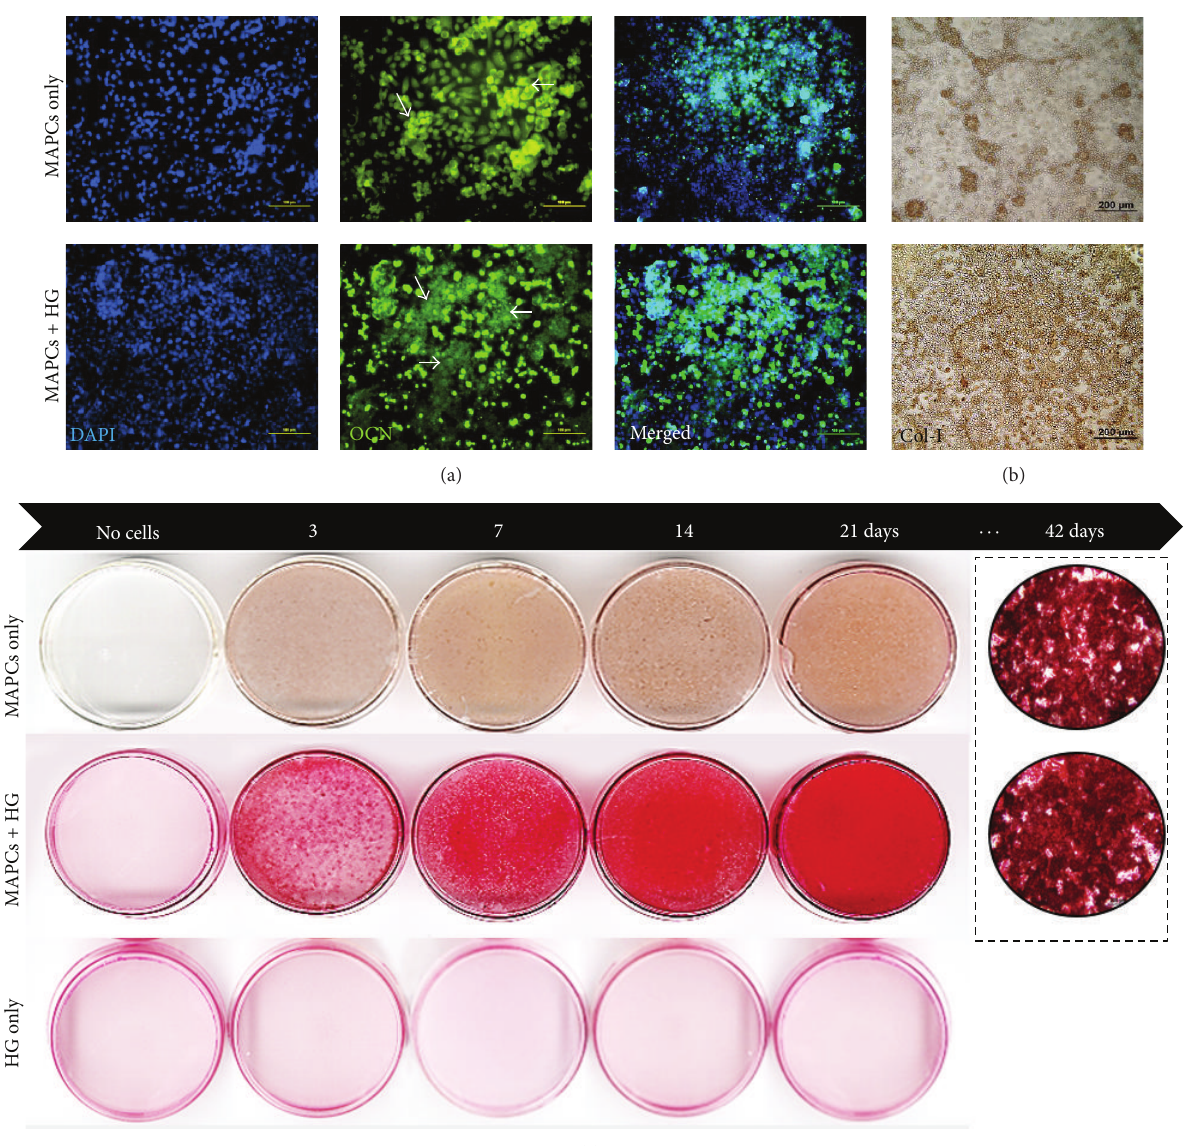
Figure 2: In vitro assessment of osteogenic differentiation of MAPCs on the HG material-coated dishes. Immunohistochemical staining with osteocalcin (a) and collagen type I (b) antibodies against MAPCs cultured on the HG coated culture plate (bottom) and without a coating as control (top). Mineral formation was detected by Alizarin Red S staining (c) after culturing MAPCs with osteogenic media on the coated dish (middle), no coating as control (top), and coated dish without MAPCs (bottom). Microscopic images further confirmed the ability of mineralization by MAPCs after 42 days of osteogenic